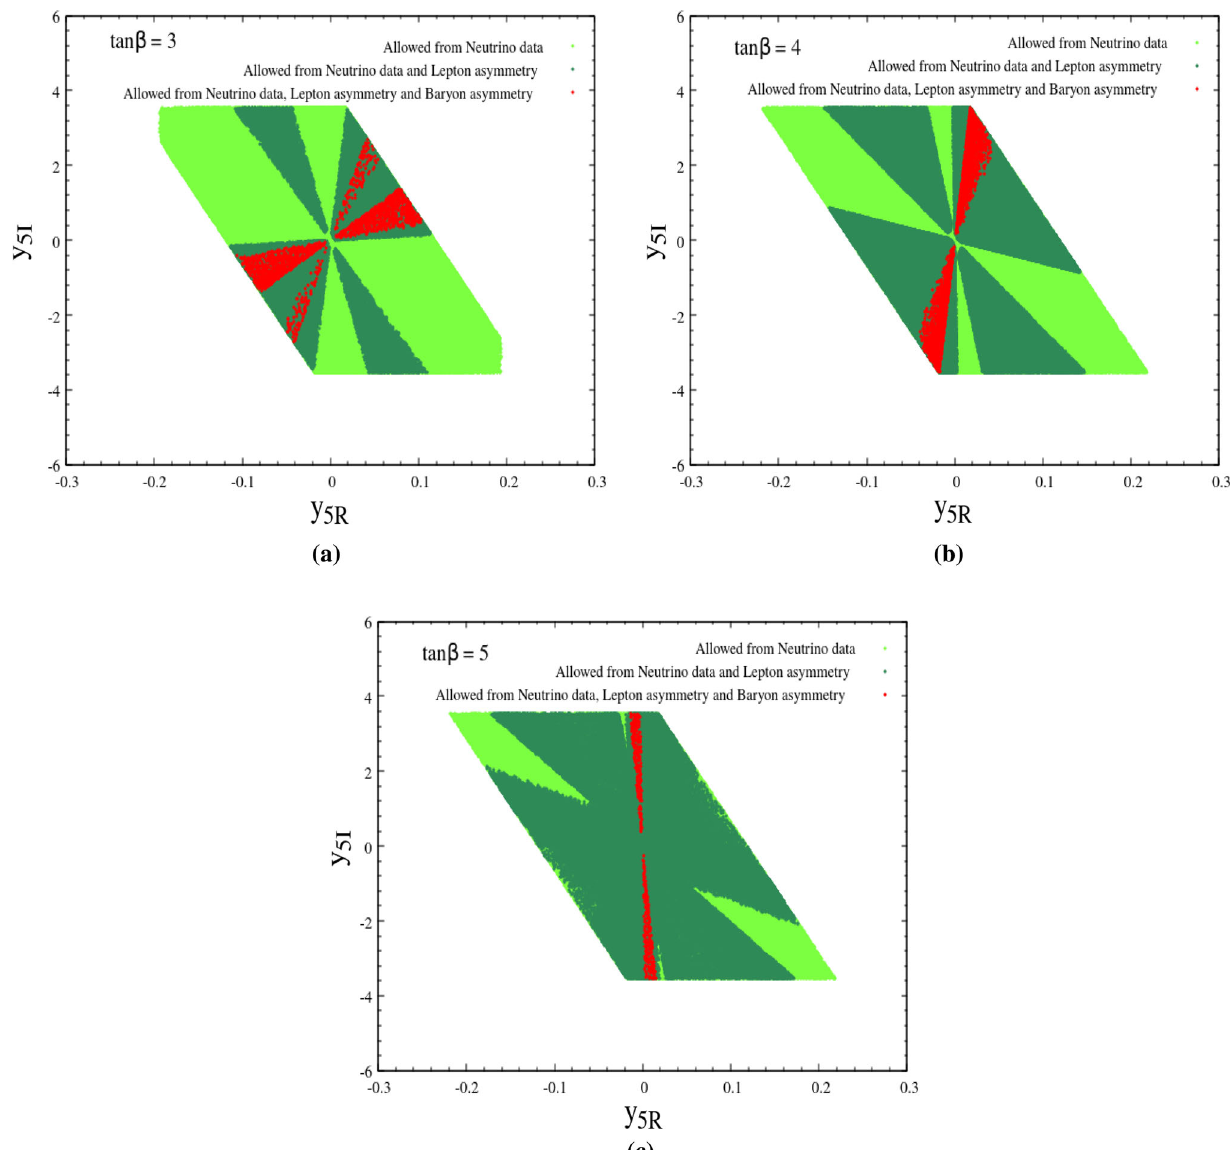
Fig. 9 Parameter space in real vs. imaginary part of Yukawa coupling y 5 . Plots are given for tan β = 3 (upper panel left), tan β = 4 (upper panel right), tan β = 5 (lower panel). Light green, deep green and